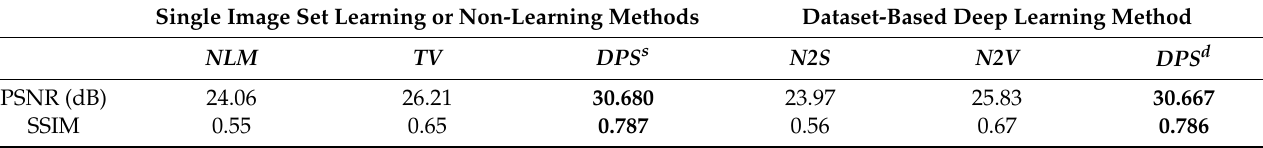
Table 1. Quantitative results from the SPARE challenge dataset. Single Image Set Learning or Non-Learning